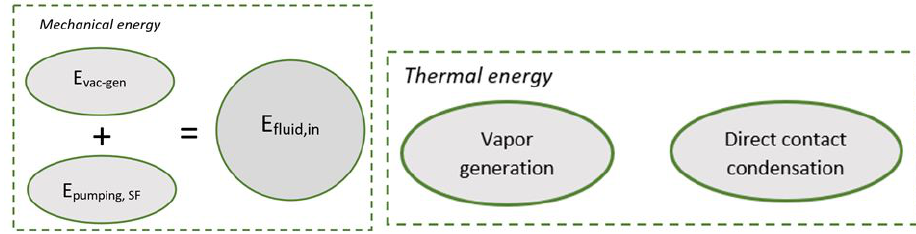
Figure 5. Fluid energy scenario in the